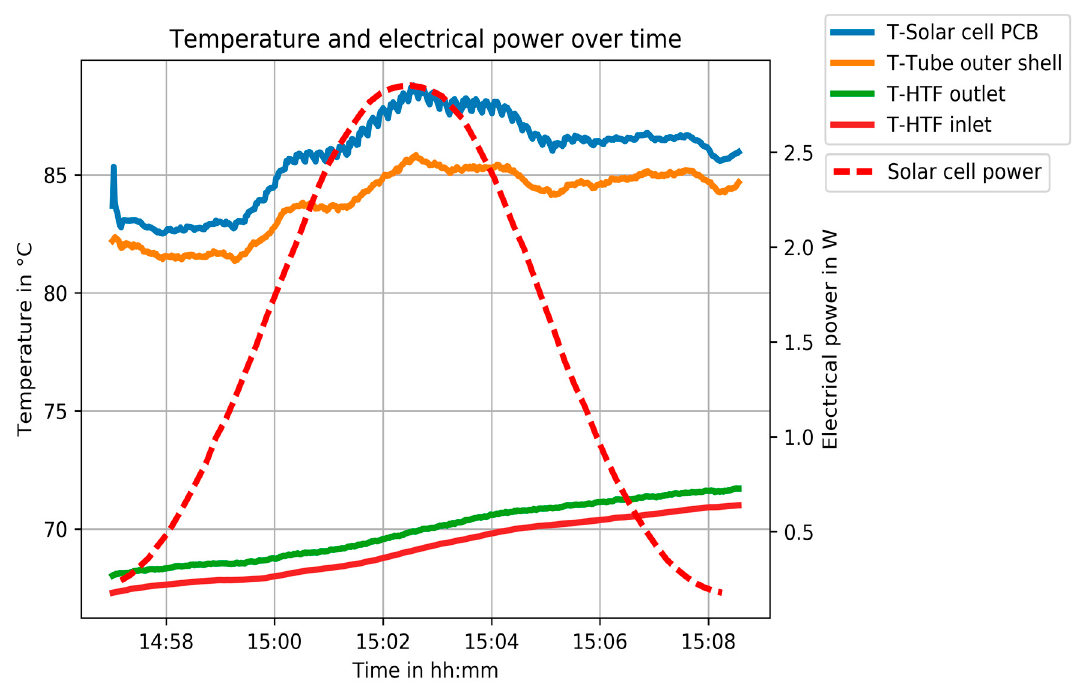
Figure 17. The temperatures (continuous lines) and the power of the solar cell (maximum power point (MPP); dashed line) shown over time. The tracking system is switched off. As the sun moves, the line focus of the concentrated sunlight passes over the solar cell and reaches the cell center at 15:02:30. The sinusoidal course of the power output is due to the movement of the sun, the data were not filtered.